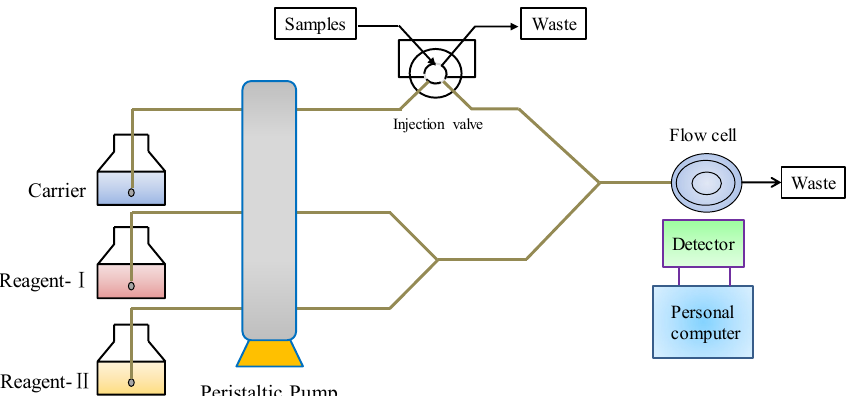
Figure 7. Schematic diagram of FI–CL analysis system.